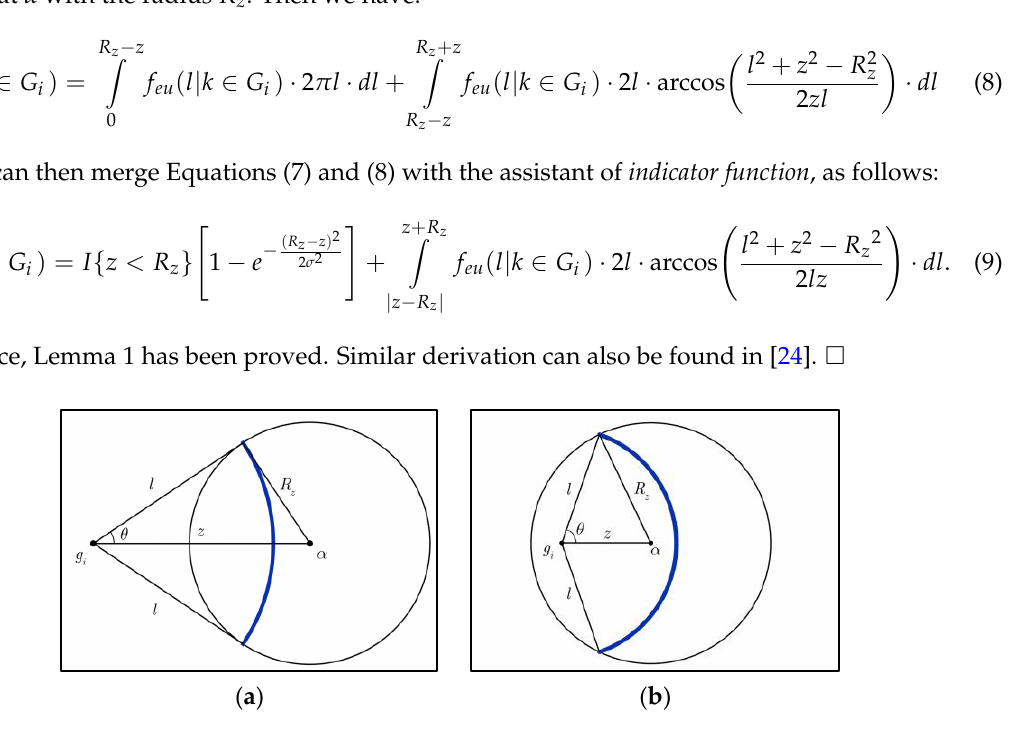
g residing in α’s communication range: ( a ) i